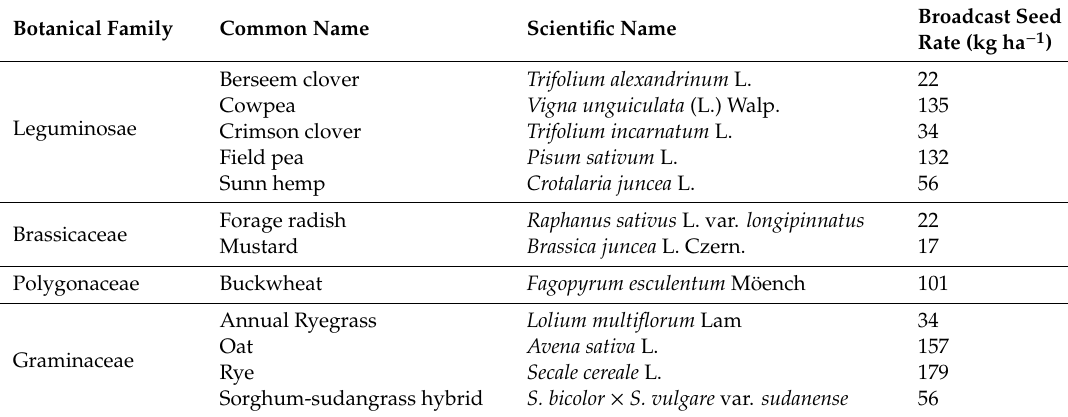
Table 1. Botanical family, common name, scientific name, and broadcast seeding rate of the cover crop species